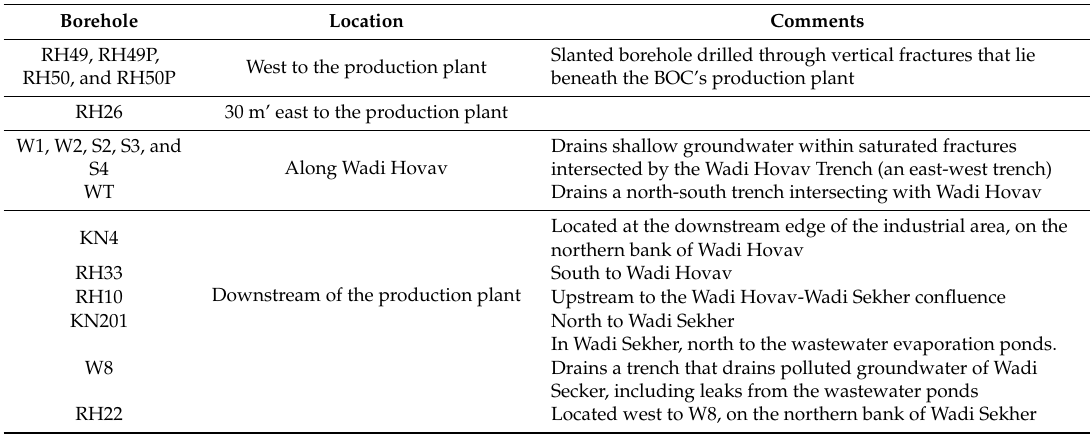
Table 1. Location of sampled boreholes and their